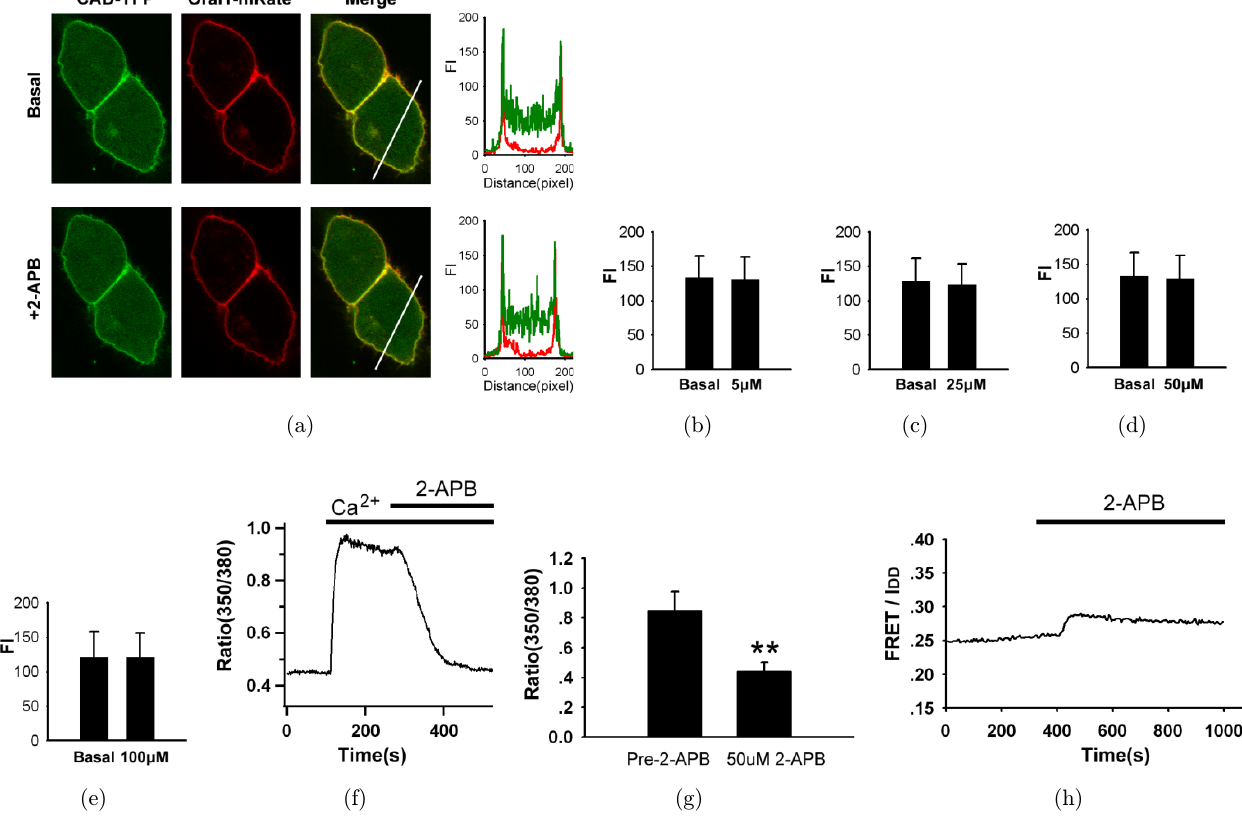
Fig. 6. 2-APB could not visibly alter near PM CAD-eYFP localization, but enhance the interaction between Orai1 and CAD. (a) Co-expression with Orai1-mKate led to an evident recruitment of CAD-eYFP to the plasma membrane (top); 50 (cid:1) M 2-APB failed to reverse the near plasma membrane CAD-eYFP localization in HEK293T cells (bottom). The right panels show pro¯les of °uorescence intensity of CAD-eYFP (green) and Orai1-mKate (red) along the lines imposed on the images. (b – e) Bar graphs show the change of PM °uorescence intensities of CAD-eYFP from various concentration 2-APB-treated experiments: 5 (cid:1) M 2-APB ( n ¼ 23), 25 (cid:1) M 2-APB ( n ¼ 22), 50 (cid:1) M 2-APB ( n ¼ 26), and 100 (cid:1) M 2-APB ( n ¼ 26). (f) CAD-eYFP-induced constitutive Ca 2 þ entry in HEK293 cells co-expressing CAD-eYFP and Orai1-eCFP was measured after Ca 2 þ -free medium replaced with 1.8 mM Ca 2 þ followed by 50 (cid:1) M 2-APB addition. (g) Bar graph shows the Fura-2 ratiometric change after 50 (cid:1) M 2-APB addition from 16 independent experiments shown in (f). (h) Change in FRET between Orai1-eCFP and CAD-eYFP in response to 50 (cid:1) M 2-APB